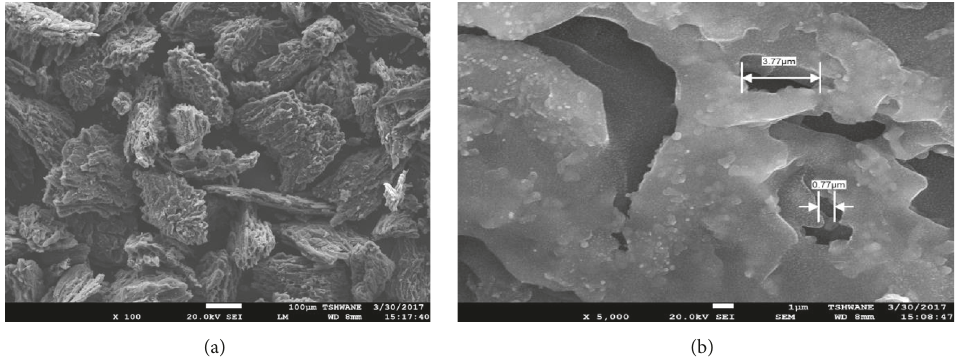
Figure 10: (a) Overview of B 4 from SEM analysis; (b) pore size distribution of B 4 at × 5000 magnification.